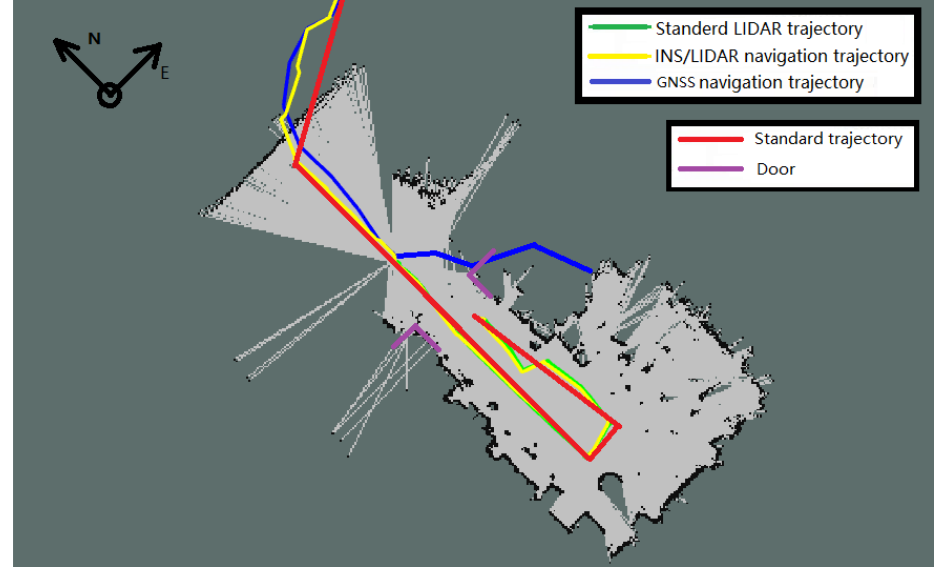
Figure 12. Comparison trajectory map of the integrated navigation algorithm (the experiment 3).